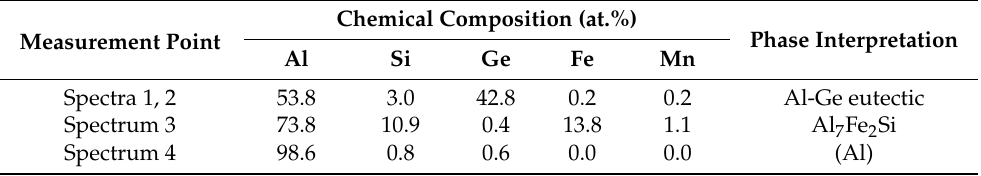
Table 4. Results of EDX analysis of the AA 6082/AA 6082 brazed joint. Chemical Composition Measurement Point